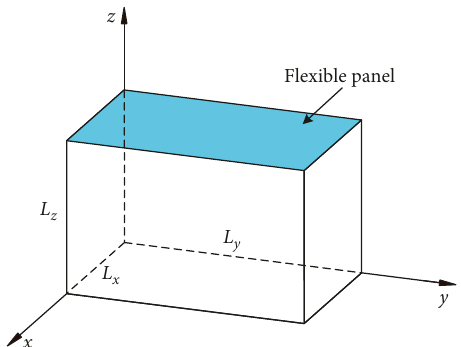
Figure 1: Panel-enclosure geometry and coordinate